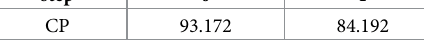
Table 5. CP value changes corresponding to Lasso. step